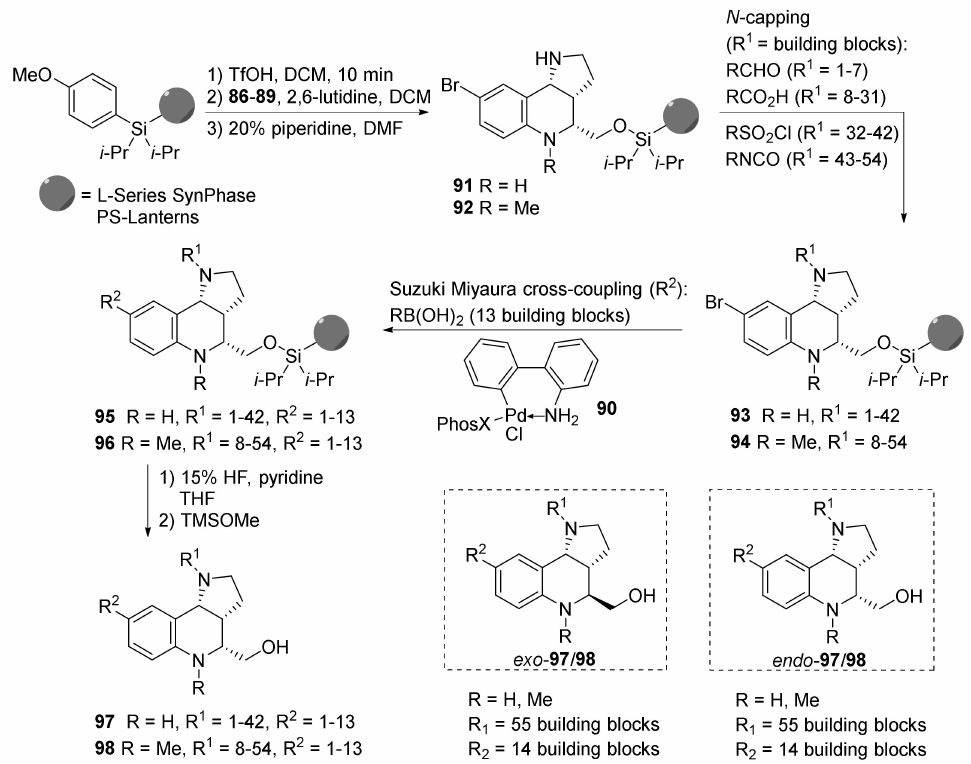
Scheme 14. Solid support scaffold diversification by Marcaurelle and